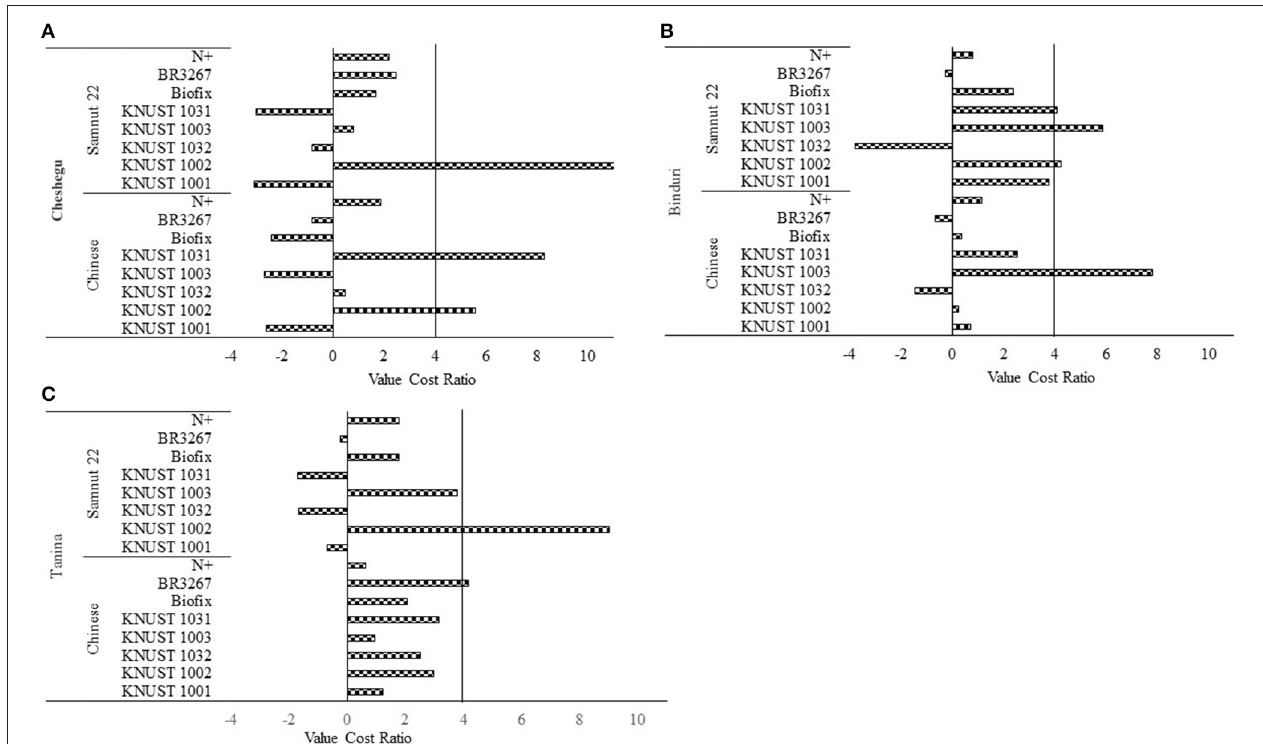
FIGURE 1 | Value cost ratio of strains on Samnut 22 and Chinese varieties Cheshegu (A) , Binduri (B) and Tanina (C) . The vertical line indicates the threshold beyond which a treatment is considered profitable.